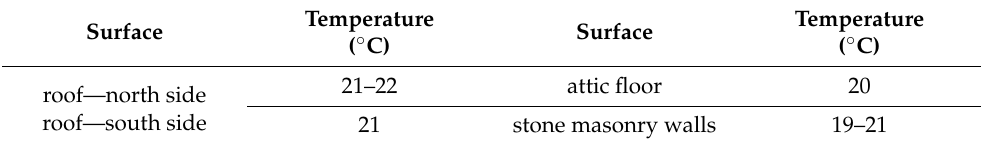
Table 10. Surface temperatures at 6:00 a.m. obtained from BPS